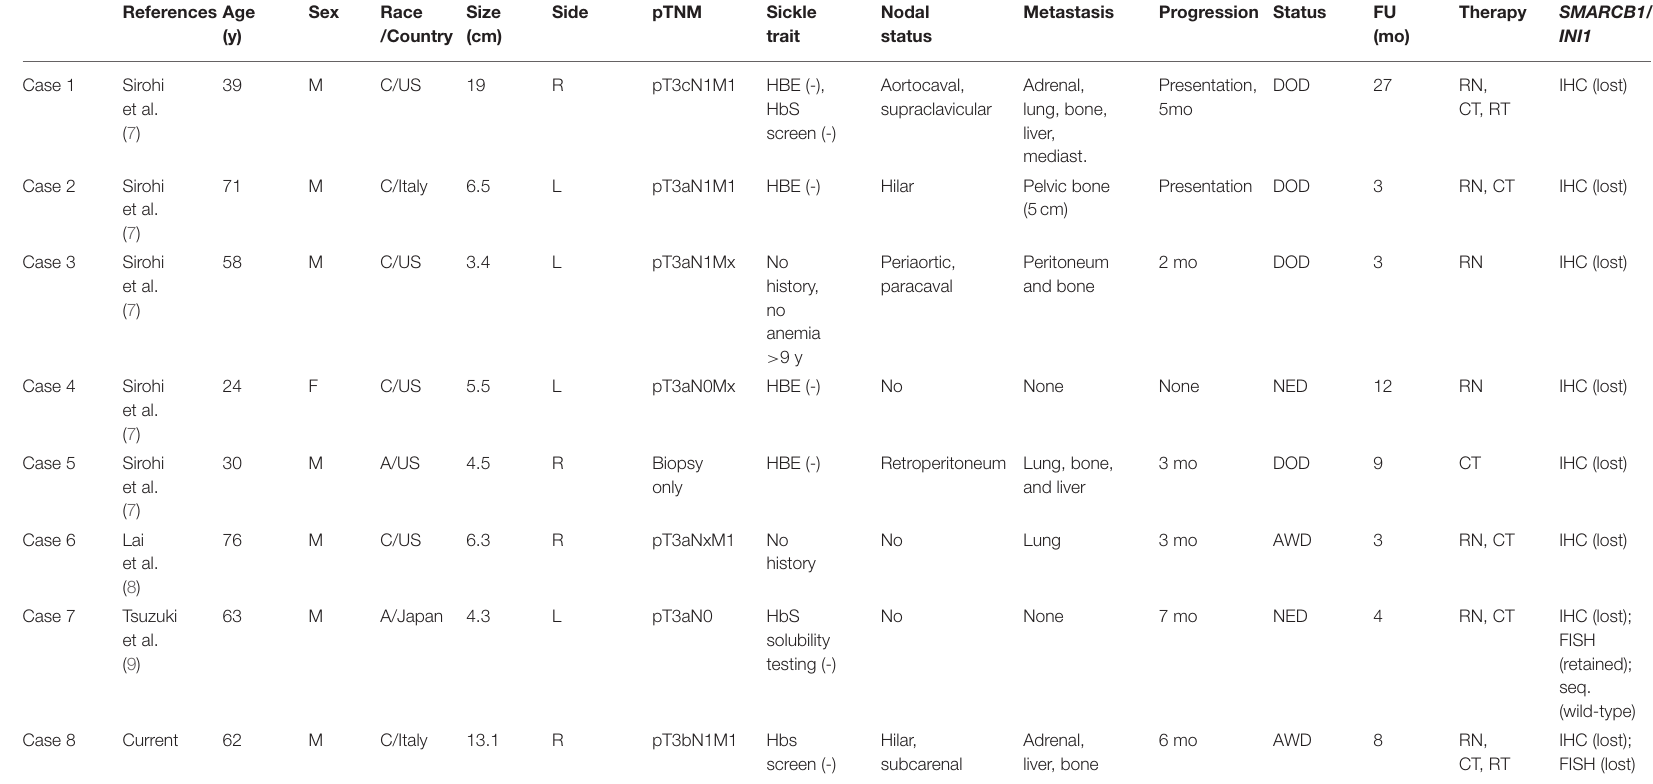
Metastasis Progression Status FU